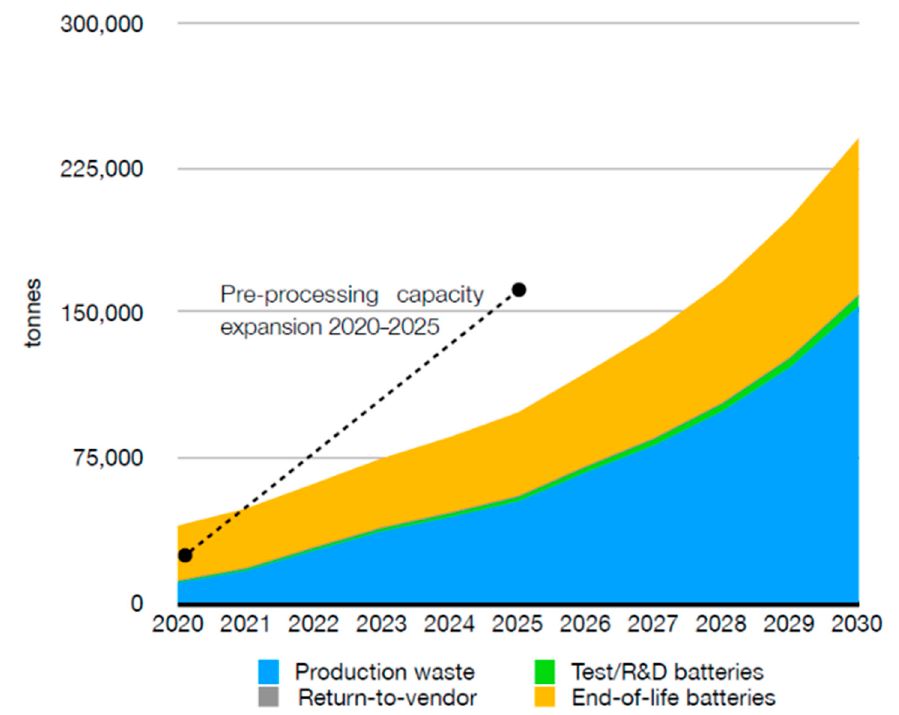
Figure 2. Total volume of LIBs available for recycling in the United States (courtesy of Circular Energy Storage).